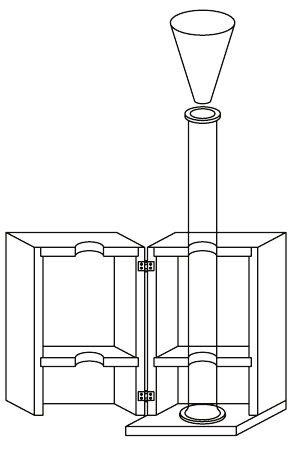
Figure 1: Device used for measuring powder tapped bulk density.